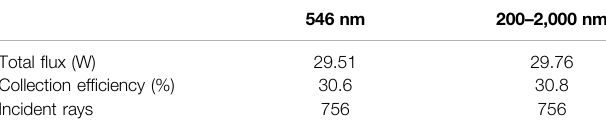
TABLE 1 | Simulation results of ray trace with two different wavelengths.